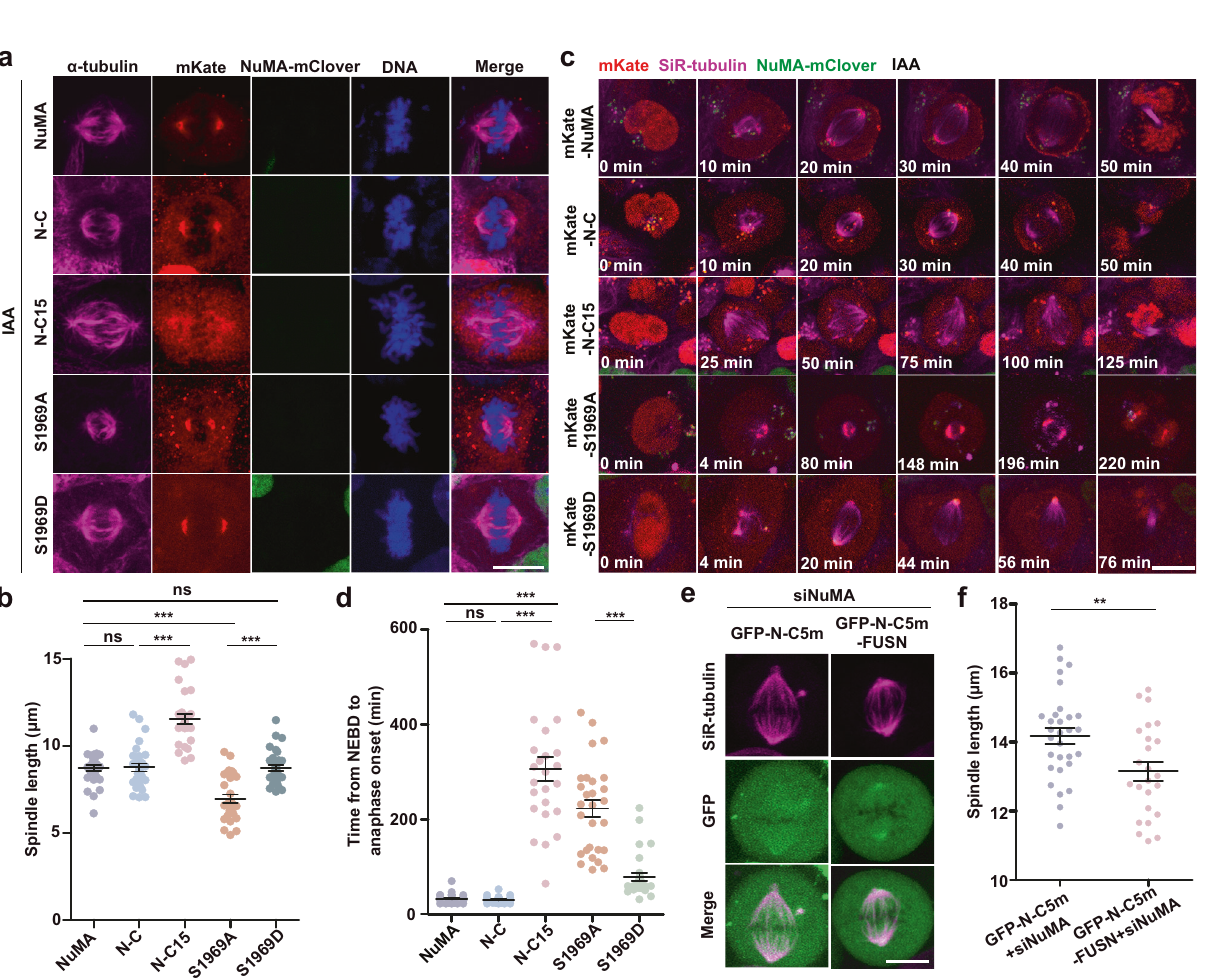
Fig. 6 NuMA concentrates Kif2A to promote microtubule fl ux. a Immunoprecipitation assay showing that NuMA interacts with Kif2A. HEK293T cells were transfected with GFP, GFP-NuMA, arrested in mitosis with nocodazole, and processed for IP assay with GFP-Trap beads. b Immuno fl uorescence images of mitotic spindles upon NuMA depletion in the control and nocodazole-treated NuMA-mACF cells, followed by staining with anti-Kif2A antibody and DAPI. c Quanti fi cation of the relative fl uorescence intensity of Kif2A on the spindle poles (mean ±SEM, n = 30 cells in 1 experiment, 3 independent experiments were repeated). The method of measurement was mentioned in Fig. 5d. Unpaired two-tailed t test: P <0.0001 for Ctrl/IAA. d Time-lapse images showing the dynamic process of exogenous Kif2A in the presence of NuMA (Ctrl) or in NuMA-depleted (IAA) cells. Images were collected every 2min. Microtubules were probed by SiR-tubulin (purple). e Immuno fl uorescence images of mitotic HeLa cells stained with anti-NuMA (green) and Kif2A (red) antibodies. f Immuno fl uorescence images of mitotic spindles in endogenous NuMA-depleted NuMA-mACF cells with stable expression of exogenous mKate-NuMA, mKate-N-C, mKate-N-C15, mKate-S1969A, or mKate-S1969D, followed by staining with anti-Kif2A antibody and DAPI for DNA. g Quanti fi cation of relative Kif2A fl uorescence intensity on spindle poles in NuMA-mACF cells treated as in f (mean ±SEM, n = 30 cells in 1 experiment, 3 independent experiments were repeated). Unpaired two-tailed t test: P = 0.1177 for NuMA/N-C, P <0.0001 for NuMA/N-C15, P = 0.0028 for NuMA/S1969A, P = 0.9229 for NuMA/ S1969D. ** P <0.01, and *** P < 0.001, ns, not signi fi cant. Scale bars, 10 μ m.